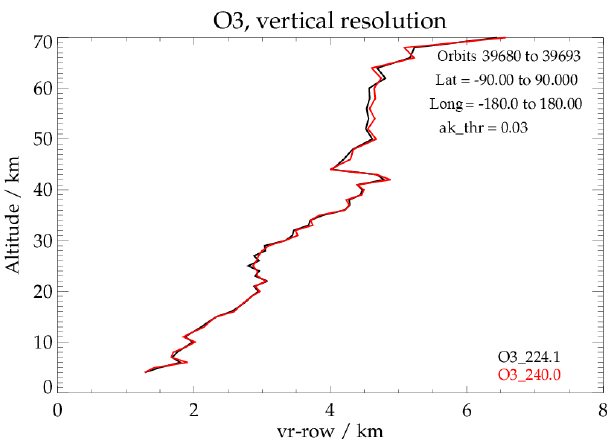
Figure 4. Vertical resolution of ozone profiles from v5 and v7, de- rived from the full-width at half maximum (FWHM) of rows of the averaging kernel